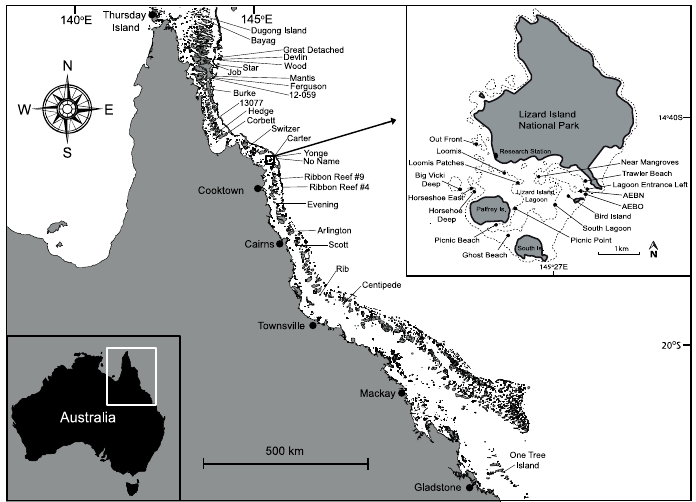
Figure 1. Location of study reefs (for reef seascape surveys and colony level surveys) along the Great Barrier Reef (GBR, 51 sites spread among 22 different reefs), spanning >1700 km (map modified from [50]) with Lizard Island subset including 16 sites, surveyed between February and November 2016. Some reefs contained more than one transect. Map template is provided by Geoscience